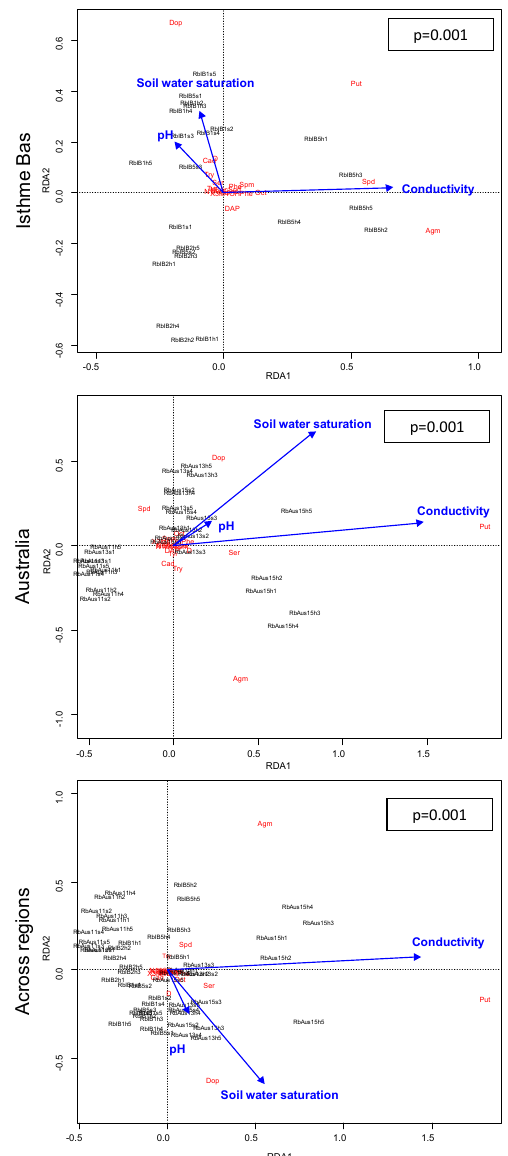
Figure 3. Full relationship between all environmental variables and all amine compounds, within and across regions, exemplified for R. biternatus . Environmental variables are soil water saturation, pH and conductivity. In redundancy analyses, axes are constrained to show, at best, variance explained by environmental variables. Individual, amines (in bold) and environmental variables (with arrows) are indicated. N = are 28 in Isthme Bas; 30 in Australia; 58 across regions. p values ( p ) are indicated. R 2 are 0.49, 0.73, ad 0.54 for Isthme Bas, Australia, and across-region, respectively. Abbreviation: Agm: Agmatine; Put: Putrescine; Spm: Spermine; Spd: Spermidine; Cad: Cadaverine; DAP: 1,3-